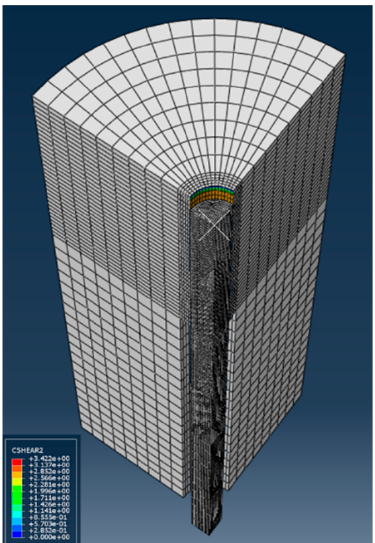
Figure 5. Bond stress observed in the contact surfaces between the concrete and steel